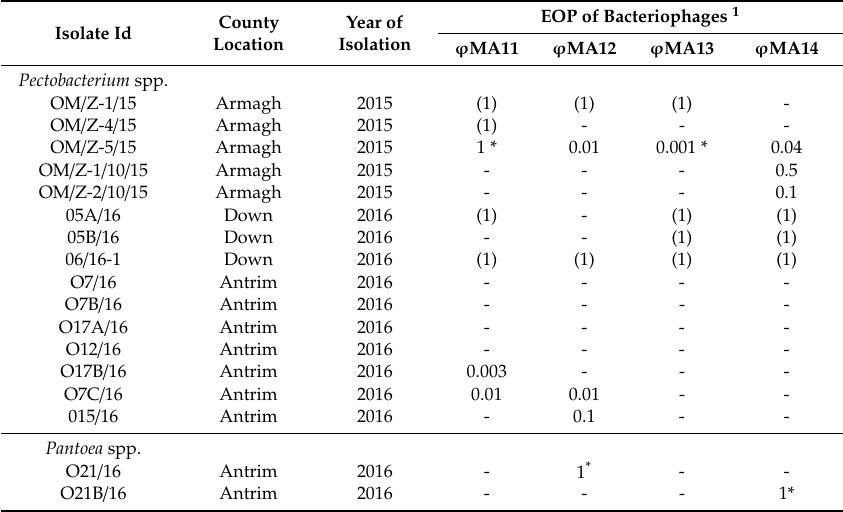
Table 3. Host range of bacteriophages used in this